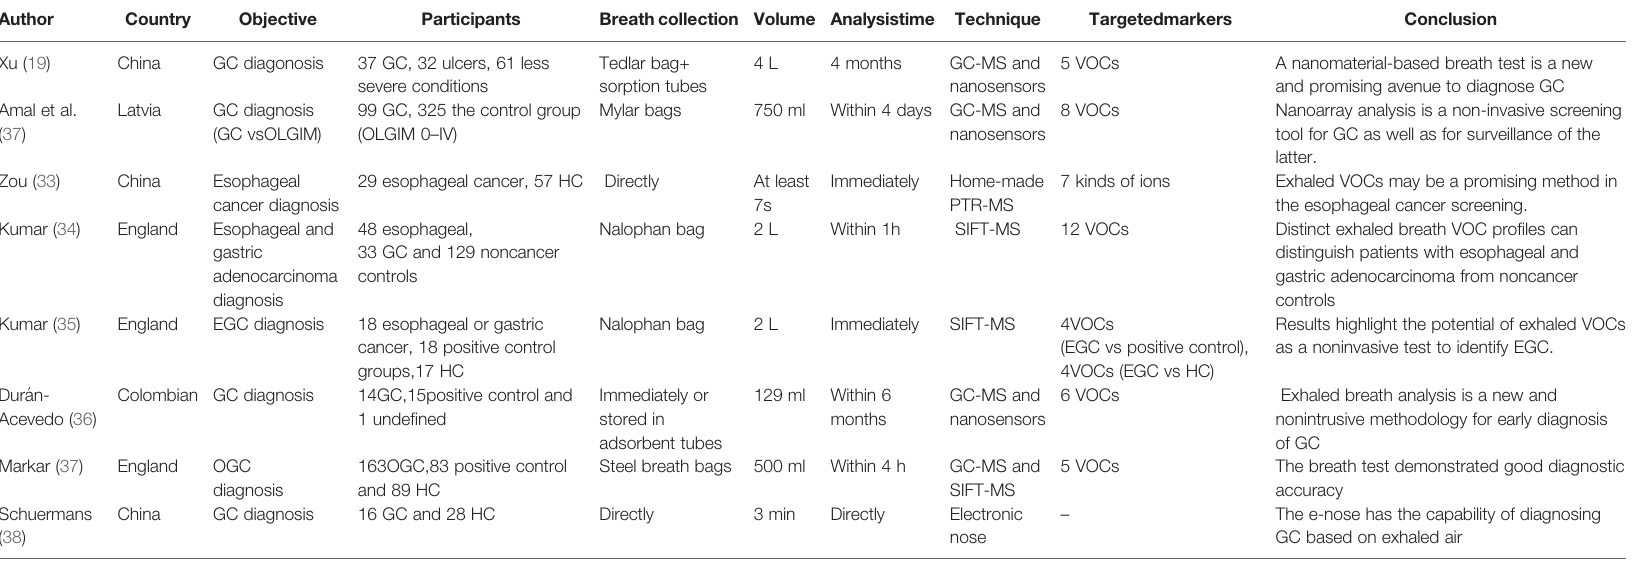
TABLE 2 | Characteristics of included studies on exhaled VOCs for GEC